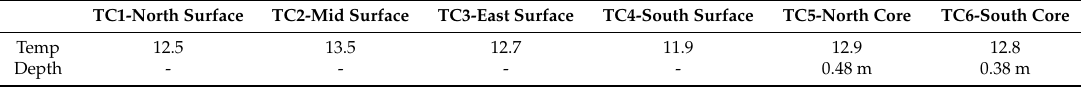
Table 4. Average temperatures at di ff erent